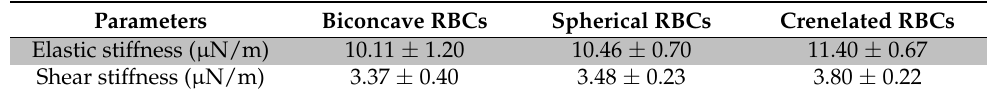
Table 1. Mechanical properties values of the studied